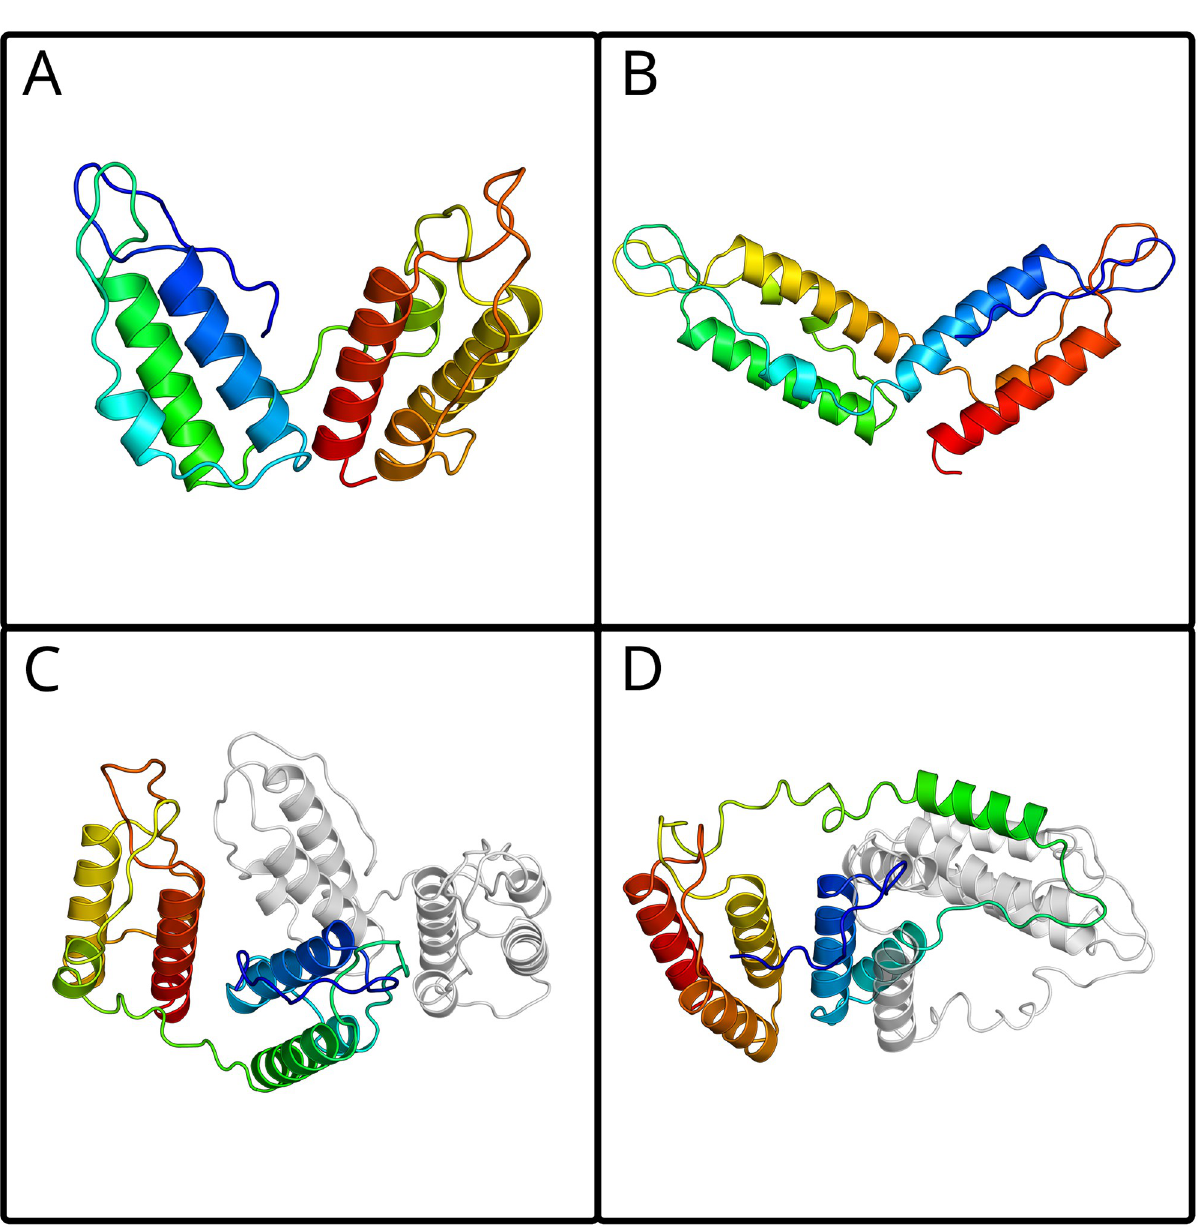
Fig 3. Examples of the topologies observed in the PolyDIV AlphaFold models. Colored from N-terminus (blue) to C-terminus (red). (A) The PURPLE_3_monomer model shows its DivIVA-like domains interacting in a consecutive manner, first with second and third with fourth. (B) The PURPLE_3+DivIVA_monomer shows a non-consecutive DivIVA-like topology. (C) PURPLE_3_dimer shows a topology equivalent to that of (A), where the two chains do not interact via their DivIVA-like domains. (D) PURPLE_1_dimer shows a complex topology where one or more DivIVA-like domains interact with another DivIVA-like domain from another polypeptide chain. All sequences and models are provided in the S1 File.